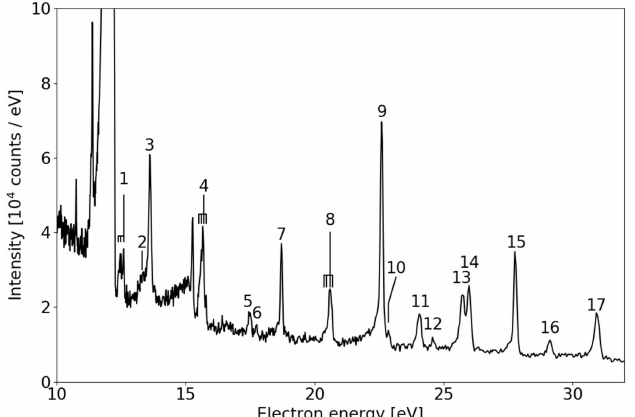
Figure 6 Low-energy part of the resonant Auger spectrum of Ne at a photon energy of 867.17 eV (resonant with the 1 s (cid:2) 1 3 p excitation), corresponding to electrons from the second step of the Auger cascade. No retardation is applied. J. Synchrotron Rad. (2022). 29 , 755–764